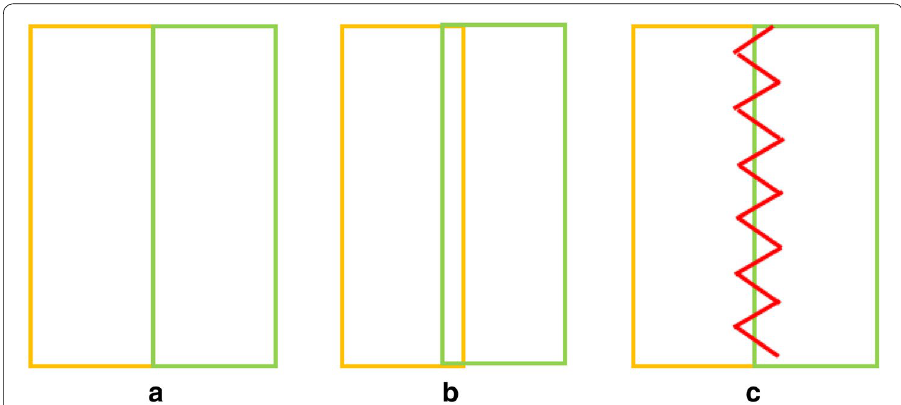
Fig. 1 Prepare two panels of neoprene fabric for flatlock stitch. a No overlap between the two panels, b 2 mm overlap between the two panels, c no overlap and zigzag stitch between the two panels